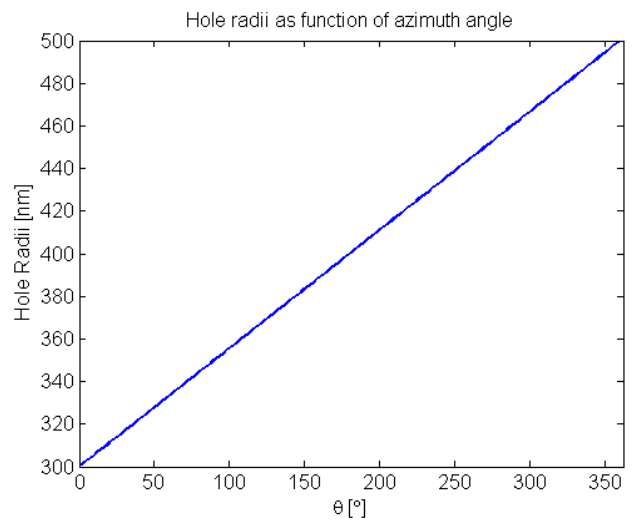
Figure 6. Hole radii variation as a function of azimuth